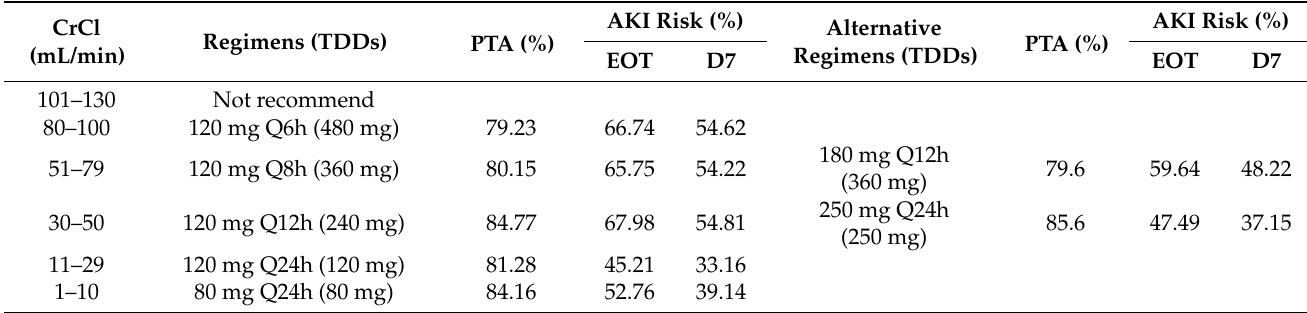
Table 7. Recommendation for MIC of 2